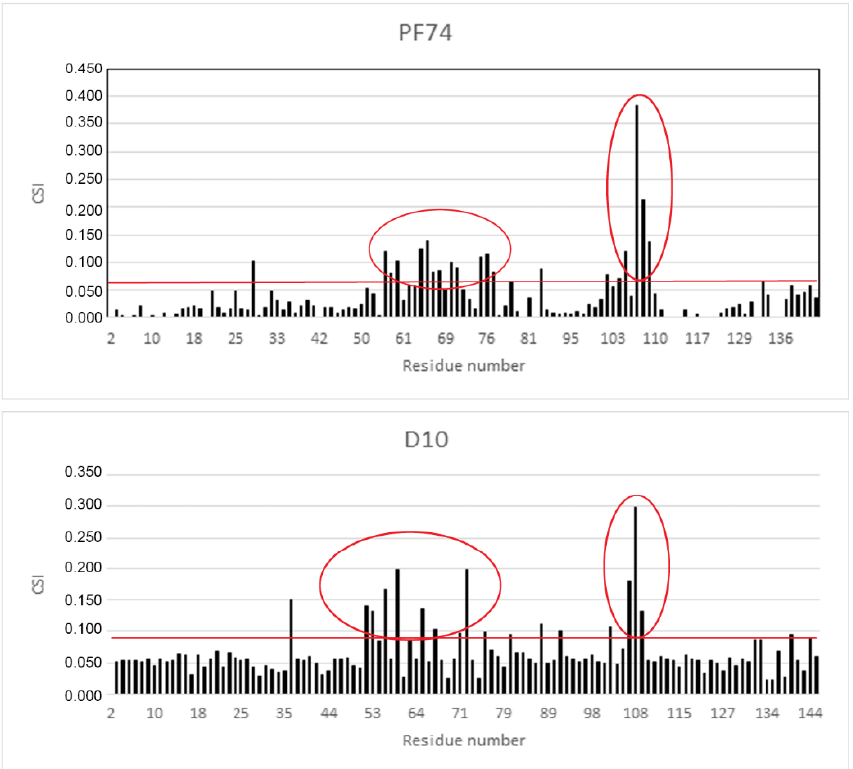
Figure 5. The chemical shift index of binding of PF74 and D10 to CA-NTD. Chemical shift changes, caused by DMSO, were subtracted from the experimental changes caused by the addition of inhibitors dissolved in DMSO. The horizontal red lines indicate the cut off, which was calculated as the average chemical shift index values (CSI) of all amino acids plus one standard deviation. The red ovals highlight the areas of substantial CSIs corresponding to the amino acids of the binding site.